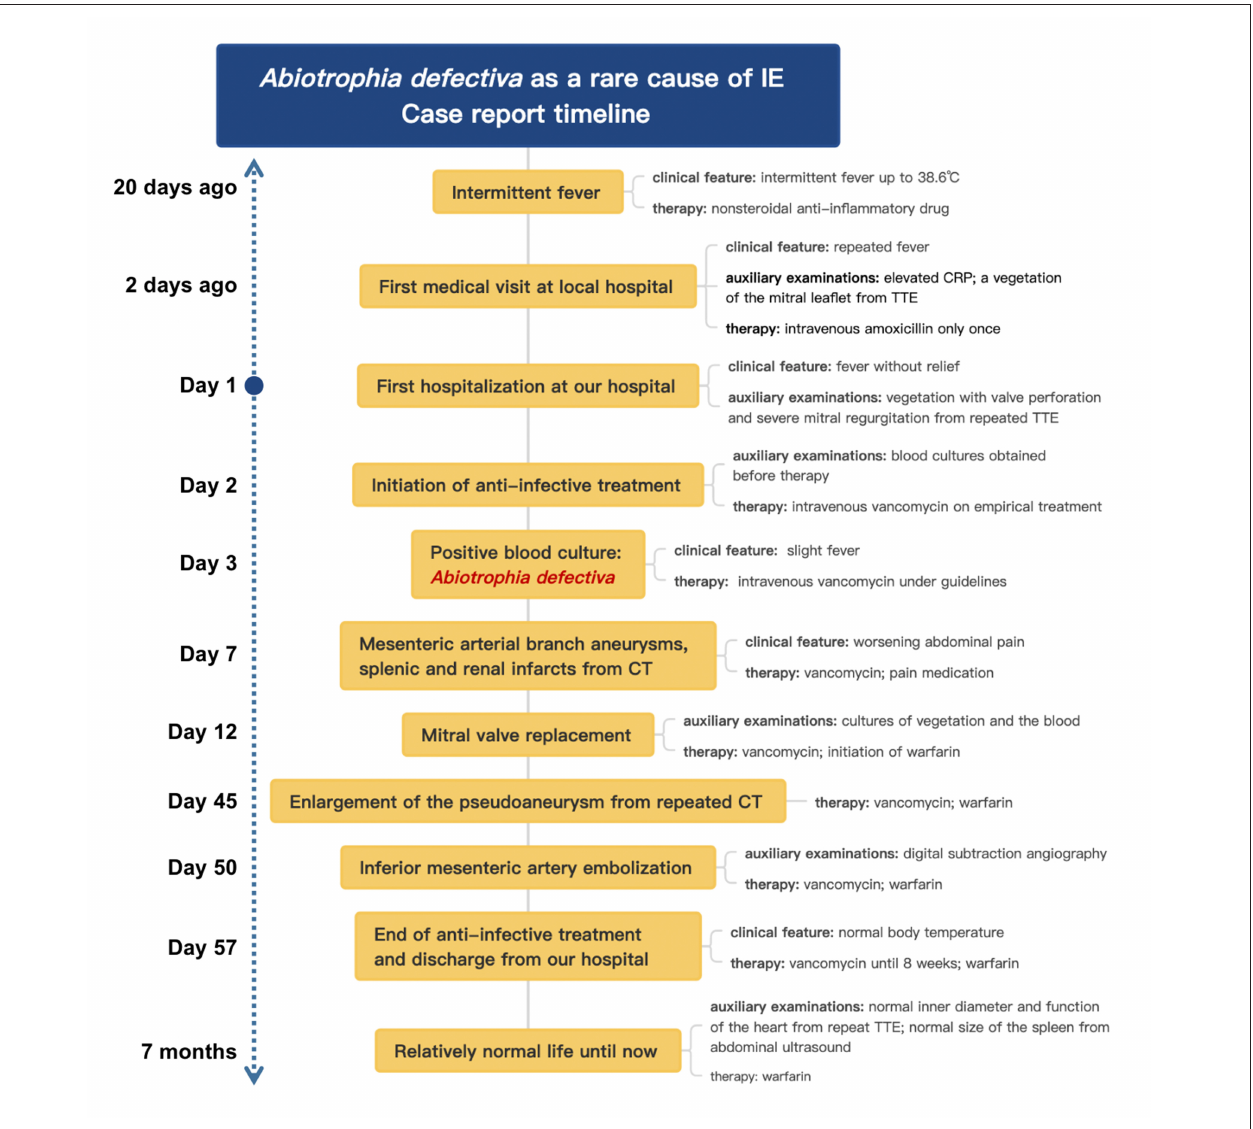
FIGURE 5 | The timeline of the